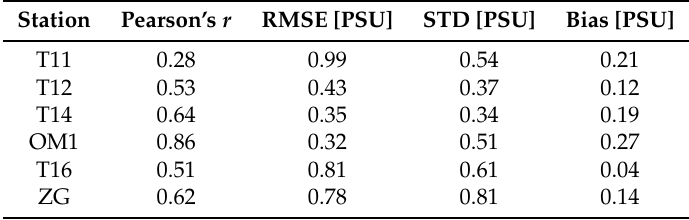
Table 7. Statistical comparison between model results and in situ measured water salinity at the surface level (VIEP).